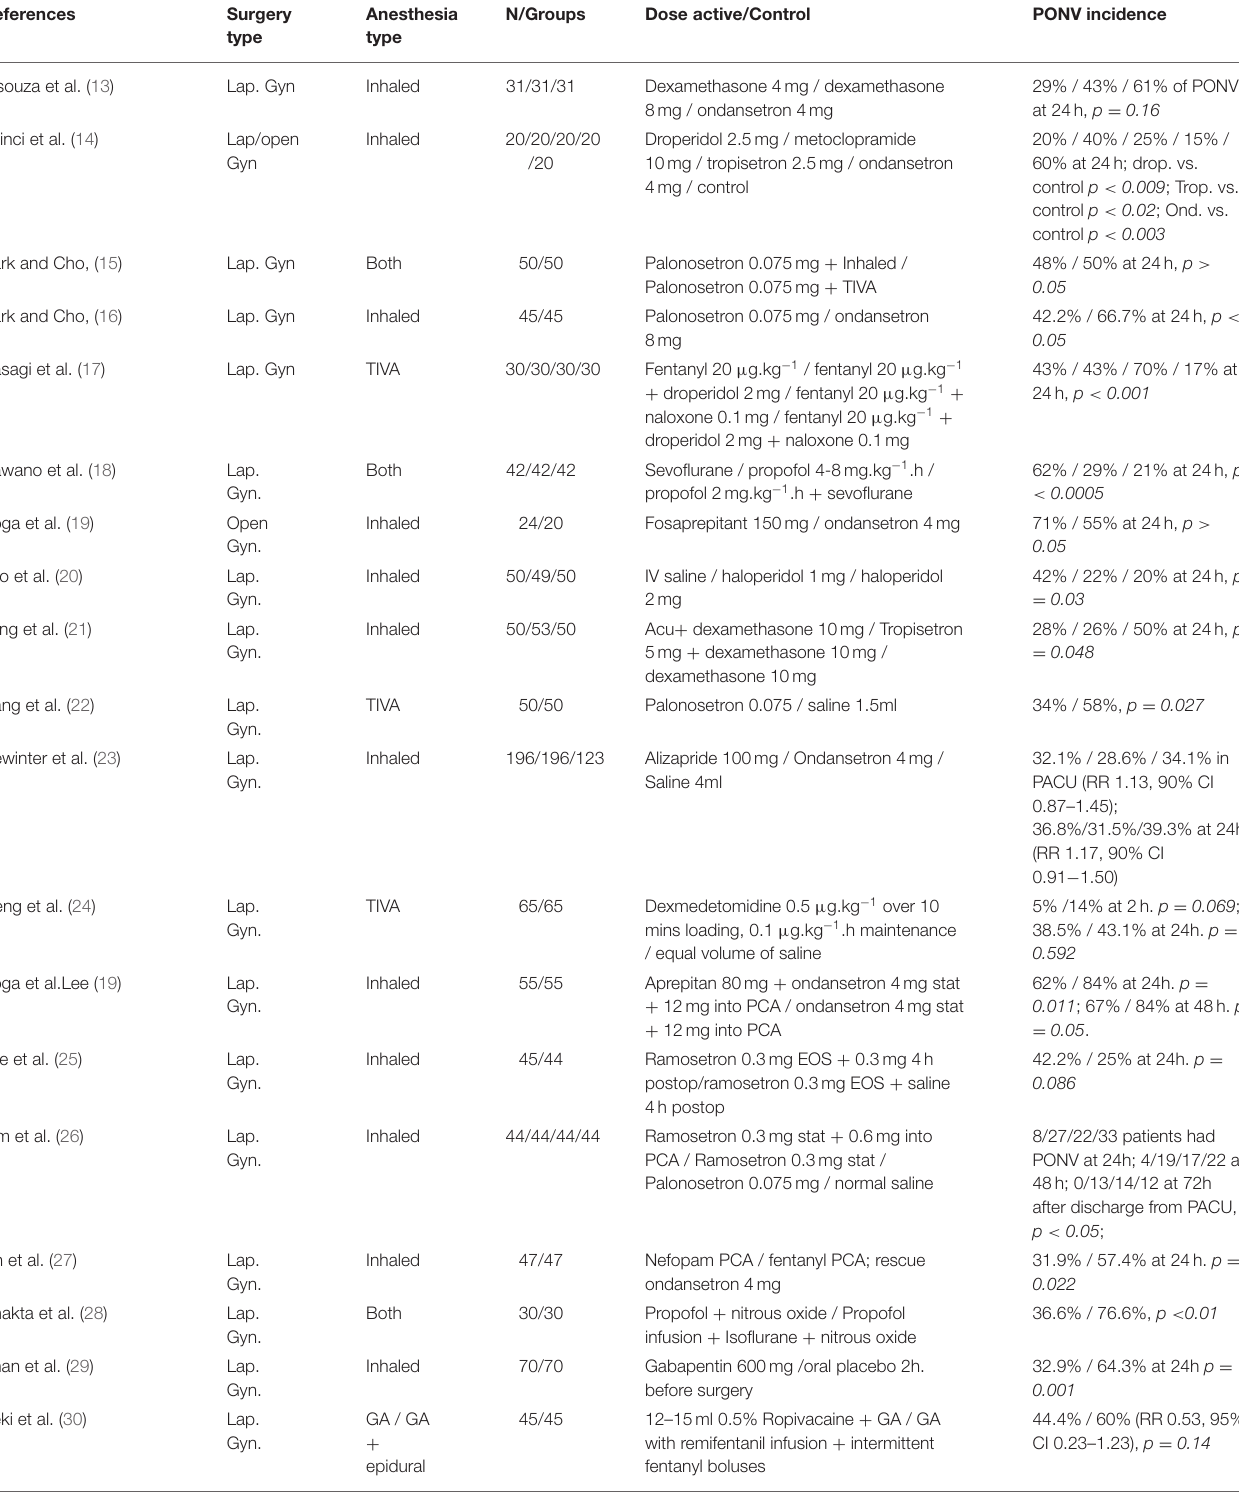
TABLE 1 | Randomized clinical trials and postoperative nausea and vomiting